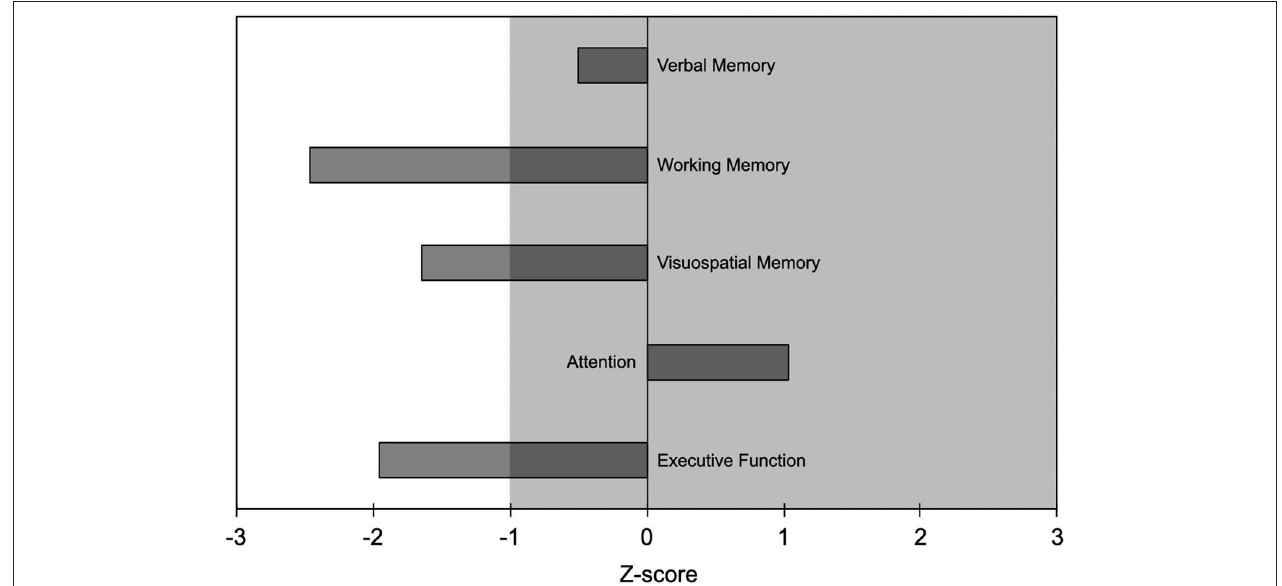
FIGURE 1 | Results of the neuropsychological evaluation from one patient (woman, age 27 years, education 8 years) who took etizolam 15mg daily. Neuropsychological findings are reported as Z-scores with negative values indicating worse performance and positive values indicating better performance than the average value of the normal population. Abnormal values are worse than mean − 1 SD; i.e., Z-scores < -1 indicate abnormal values. Shaded area indicates normal range of